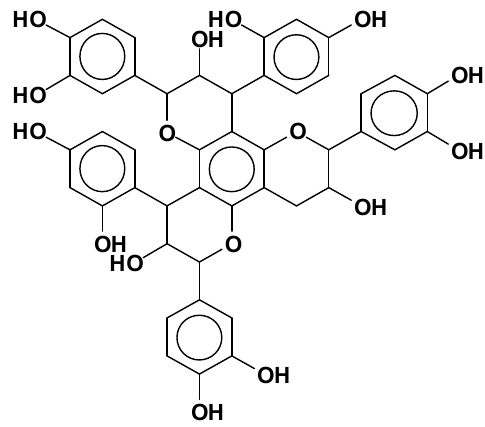
Figure 3. Chemical structure of phlobaphenes.